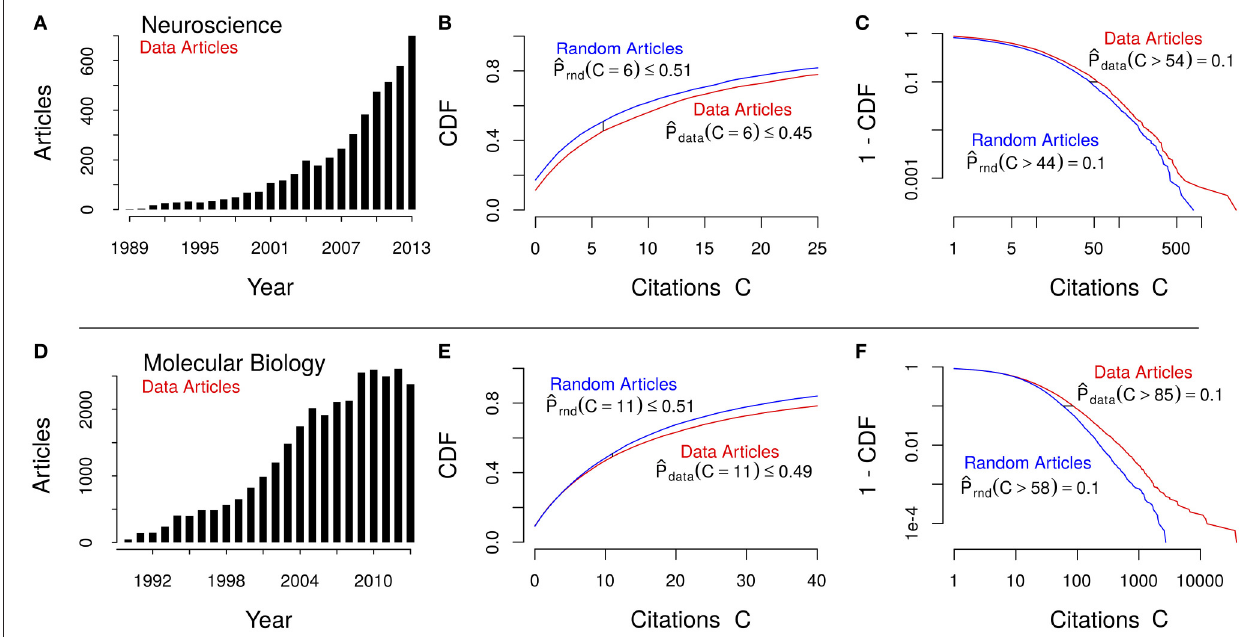
FIGURE 1 | Comparative study of empirical data (red) and random article (blue) citation distributions for neuroscience (top, A–C) and molecular biology (bottom, D–F). Left (A,D) : Histogram of the number of data articles published per year. Middle (B,E) : Cumulative distribution function (CDF) over the first few citation counts C (x-axis), showing the observed probability for the median citation value of average articles ( C = 6 and C = 11, respectively). Right (C,F) : Log-log plots of the complementary (1 - CDF) visualizing the growing gap between the data and random citation distributions in the heavy tails. The small horizontal black line marks the observed citation count difference for articles in the top decile ( P = 0.1; i.e., the 10% most cited